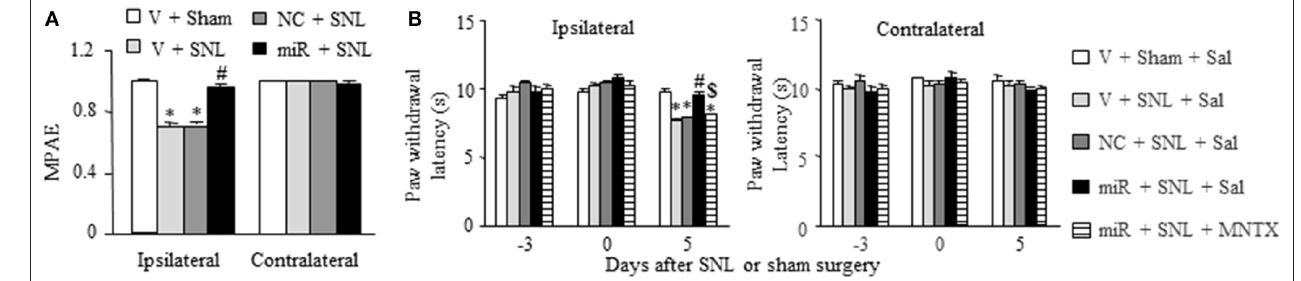
FIGURE 7 | Rescuing DRG miR-143 expression improved morphine analgesia under neuropathic pain conditions. miR, microRNA; NC, negative control; SNL, spinal nerve ligation; Veh, vehicle; (A) Microinjection of miR-143 mimics, but not negative control, into the ipsilateral L5 DRG reversed the decrease in morphine analgesia on the ipsilateral side 5 days after SNL. MPAE, maximal possible analgesic effect; n = 5 rats/group. One-way ANOVA followed by Tukey post-hoc test. * P < 0.05 vs. the corresponding vehicle plus sham group. # P < 0.05 vs. the corresponding vehicle plus SNL group. (B) Intraperitoneal injection with methylnatrexone (MNTX) blocked the miR-143 mimics-induced antinociception on day 5 post-SNL in the ipsilateral side of the miR-143 mimics plus SNL group. MNTX was administered on day 5 post-SNL or sham surgery. Behavioral tests were carried out 30min after drug administration. n = 5 rats/group. Two-way ANOVA followed by Tukey post-hoc test. * P < 0.05 vs. the vehicle plus sham plus saline (Sal) group at the corresponding time point. # P < 0.05 vs. the vehicle plus SNL plus saline group at the corresponding time point. $ P < 0.05 vs. the miR-143 mimics plus SNL plus saline group at the corresponding time